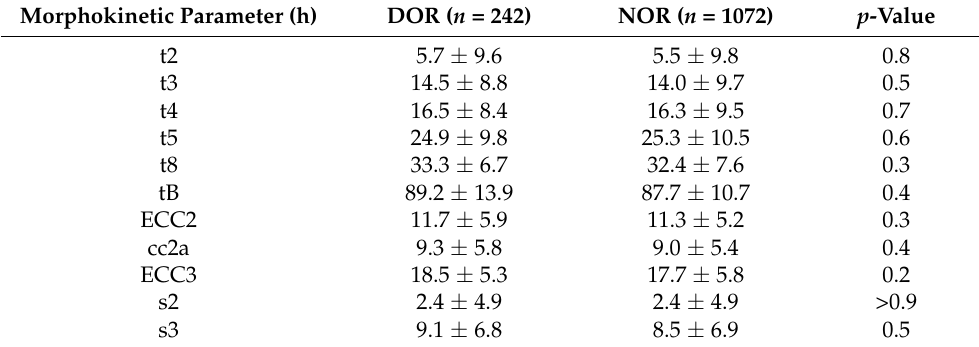
Table 3. Absolute and relative morphokinetic events of embryos from patients with Diminished Ovarian Reserve (DOR) compared to patients with Normal Ovarian Reserve (NOR). Values are shown as mean ± SD.